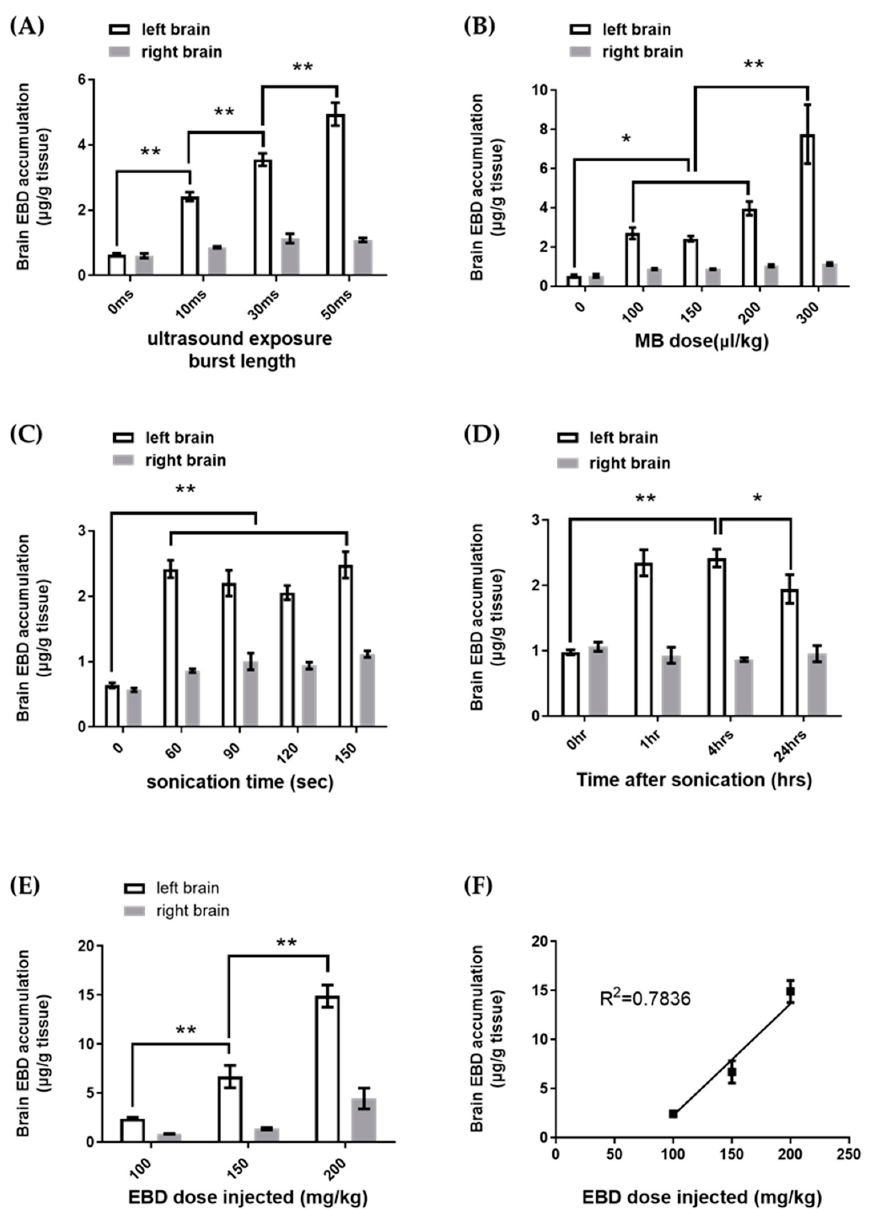
Figure 3. The result of the parameter study. The experimental conditions of each group are listed in Table 1. * Indicates p < 0.05, ** indicates p < 0.0001. ( A ) Brain EBD accumulation increased as burst length increased. ( B ) Brain EBD accumulation was similar with MB doses 100–200 µ L/kg, but significantly increased with MB dose 300 µ L/kg. ( C ) Brain EBD accumulation was similar with four different sonication time used. ( D ) Brain EBD accumulation peaked in one hour after sonication and maintained 81% of the peak level 24 h after sonication. ( E , F ) Brain EBD accumulation is correlated to the EBD dose injected in the case of BBBD, with a correlation coefficient of